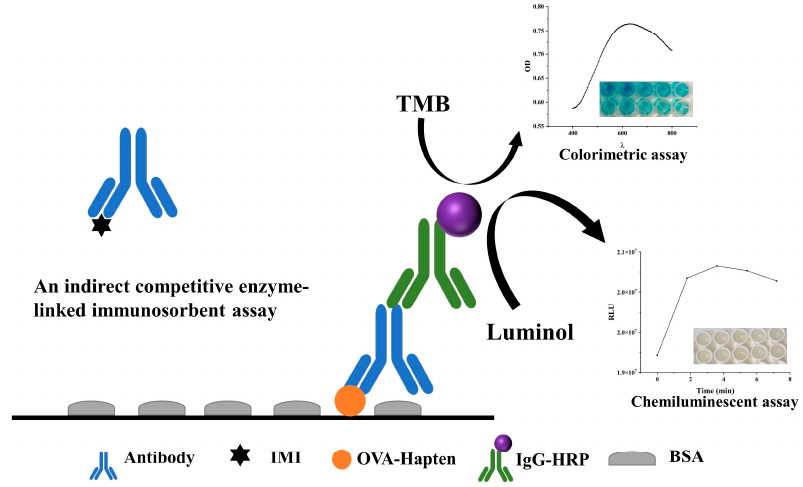
Figure 1. Illustration of the principle of Co-ELISA and Cl-ELISA.